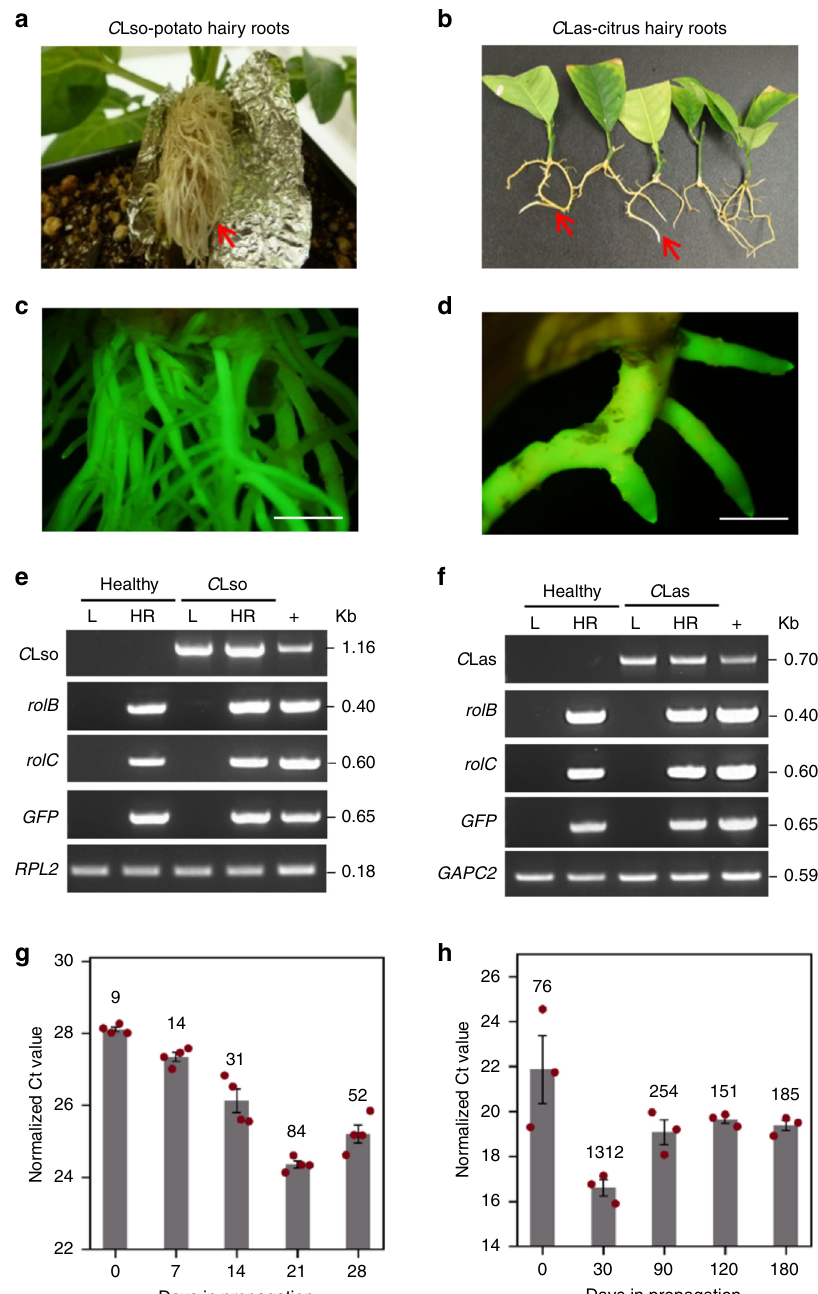
Fig. 1 Candidatus Liberibacter solanacearum and Candidatus Liberibacter asiaticus in potato and citrus hairy roots. a , b Hairy roots (indicated by arrows) from Candidatus Liberibacter solanacearum ( C Lso)-infected potato ( a ) and Candidatus Liberibacter asiaticus ( C Las)-infected citrus explants ( b ). c , d Visual con fi rmation of GFP expression in hairy roots by fl uorescence microscopy. Scale bars, 1 cm. e , f Detection of C Lso and C Las in the hairy roots by PCR ampli fi cation of diagnostic markers speci fi c to C Lso (16S rDNA) and C Las (rplk04/J5 and RNR). GFP , rolB , and rolC encoded on the Ti and Ri plasmids, respectively, and co-transformed into the hairy roots, were used as additional markers for hairy root authenticity; RPL2 and GAPC2 are endogenous potato and citrus genes, respectively, used as genomic DNA controls for PCR. “ L ” and “ HR ” indicate leaf and hairy root samples, respectively. “ + ” indicates positive controls used for the respective PCR ampli fi cations. g , h Temporal growth curves of C Lso and C Las in the hairy roots. The Ct values of C Lso and C Las in hairy root samples collected at different days in propagation are plotted, whereas the approximate genome equivalents (GE) per nanogram of root genomic DNA are indicated above the bar graph columns. Error bars represent ± standard error of mean ( n = 4 and n = 3 for g and h , respectively). Uncropped raw agarose gel images used to prepare e and f are presented in Supplementary Fig. 10. Source data underlying Fig. 1g, h are provided as a Source Data fi